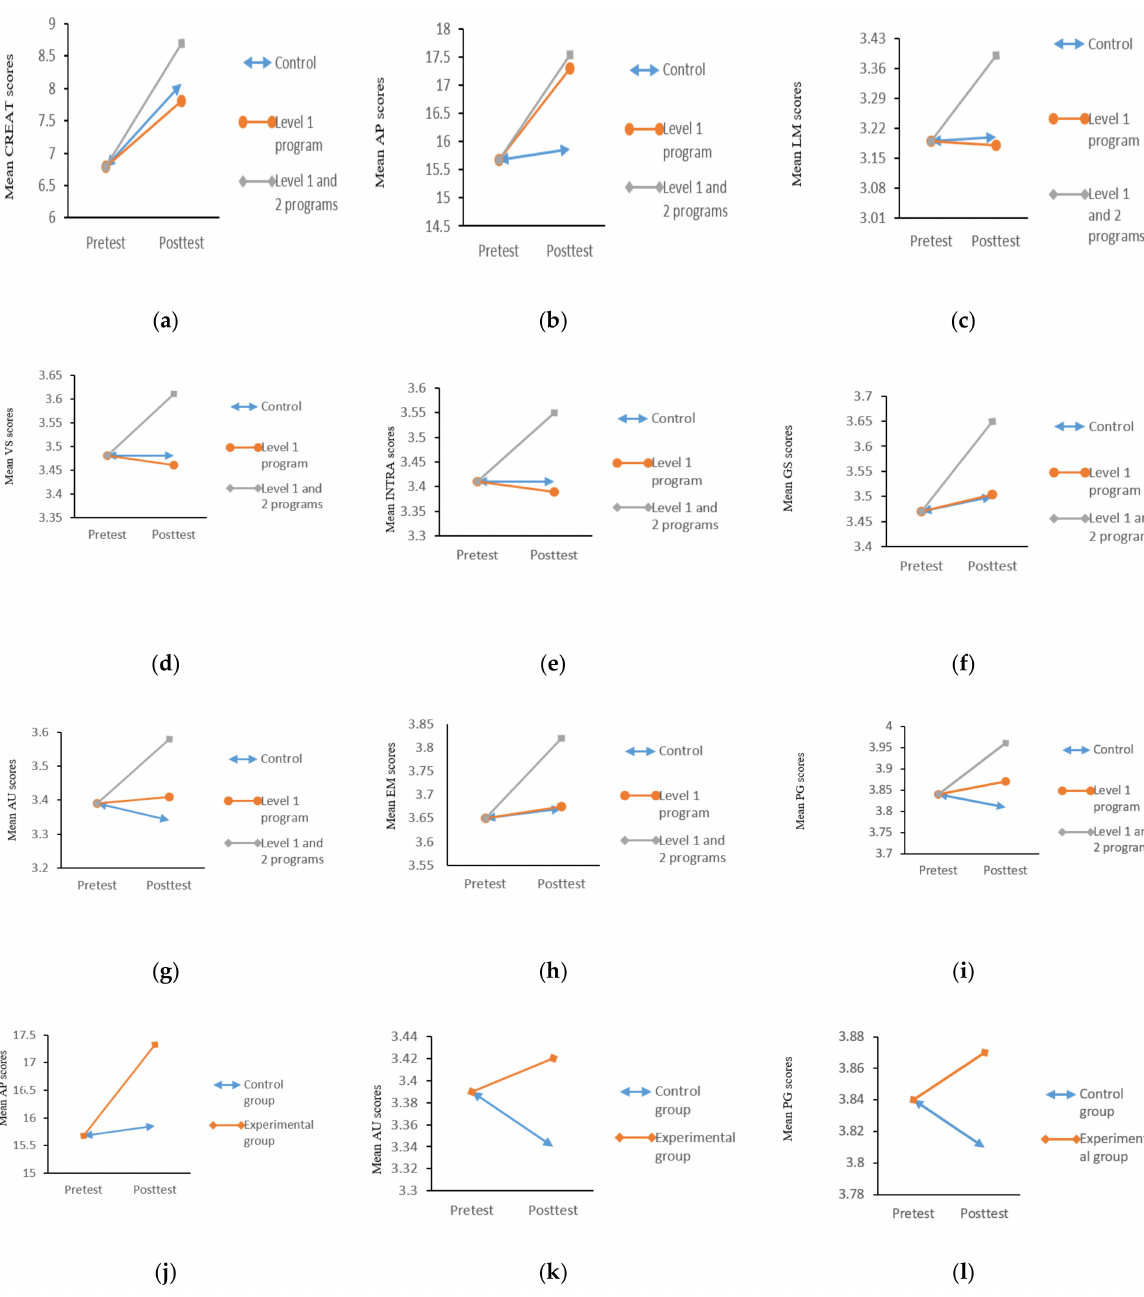
Figure 3. ( a – l ) Graphs showing the difference in outcome variables at post-test from one-way AN- COVA amongst Level 1 program, Level 1 and 2 programs, and the Control ( a – i ). Graphs showing the difference in outcome variables at post-test from one-way ANCOVA between experimental and control groups ( j – l ). ( a ). CREAT (creativity), Note: F(2,3178) = 5.30, p =0.005, ( b ). AP (Academic performance), Note: F(2,3177) = 40.42, p = 0.000, ( c ). LM (logical–mathematical intelligence), Note: F(2,3179) = 5.06, p = 0.006, ( d ). VS (visual–spatial intelligence), Note: F(2,3179) = 3.08, p = 0.046, ( e ) INTRA (intrapersonal intelligence), Note: F(2,3179) = 3.90, p = 0.020, ( f ). GS (self-efficacy), Note: F(2,3179) = 3.84, p = 0.022, ( g ). AU (autonomy), Note: F(2,3179) = 5.98, p = 0.003, ( h ). EM (environ- mental mastery), Note: F(2,3179) = 3.13, p = 0.044, ( i ). PG (personal growth), Note: F(2,3179) = 3.56, p = 0.029, ( j ). AP (academic performance), Note: F(1,3178) = 80.30, p = 0.000, ( k ). AU (autonomy), Note: F(1,3180) = 5.24, p = 0.022, ( l ). PG (personal growth), Note: F(1,3180) = 4.33, p =